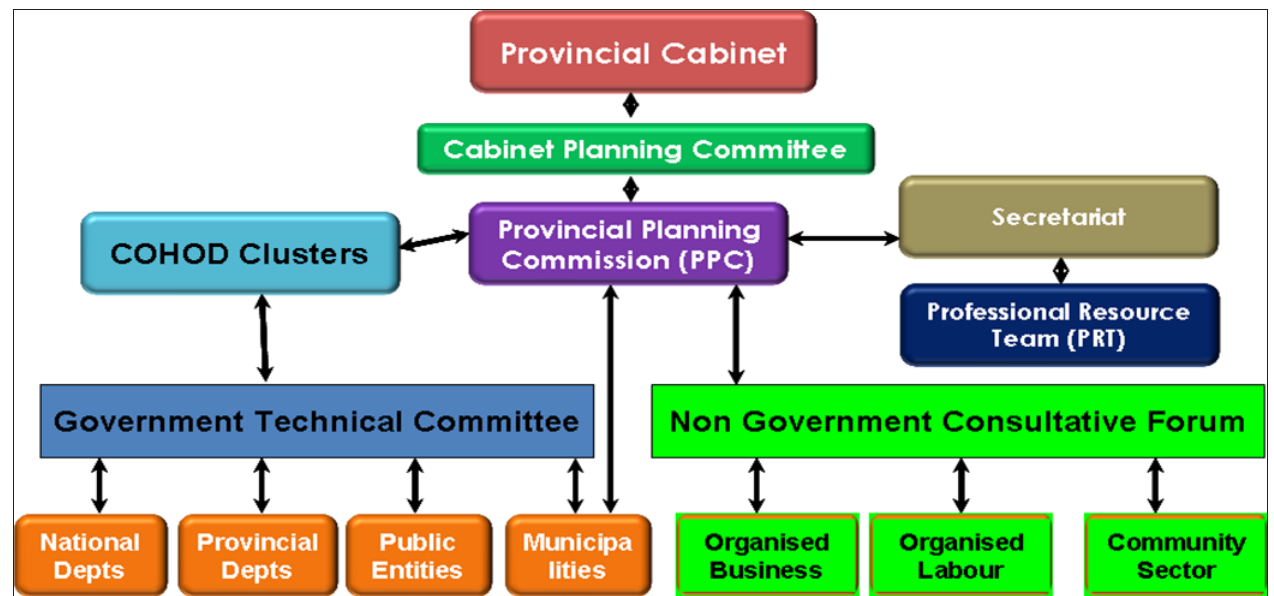
Figure 5: Depiction of Provincial Cabinet, Clusters and Provincial Planning